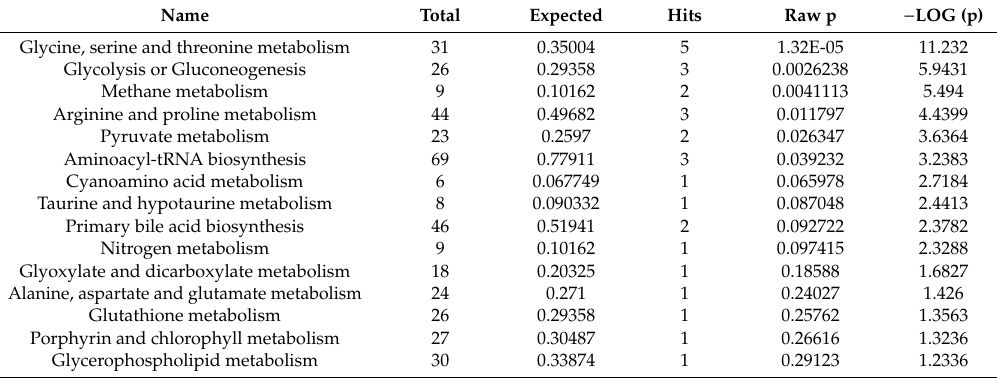
Table 4. Pathway analysis associated with the di ff erential SPPM60-D